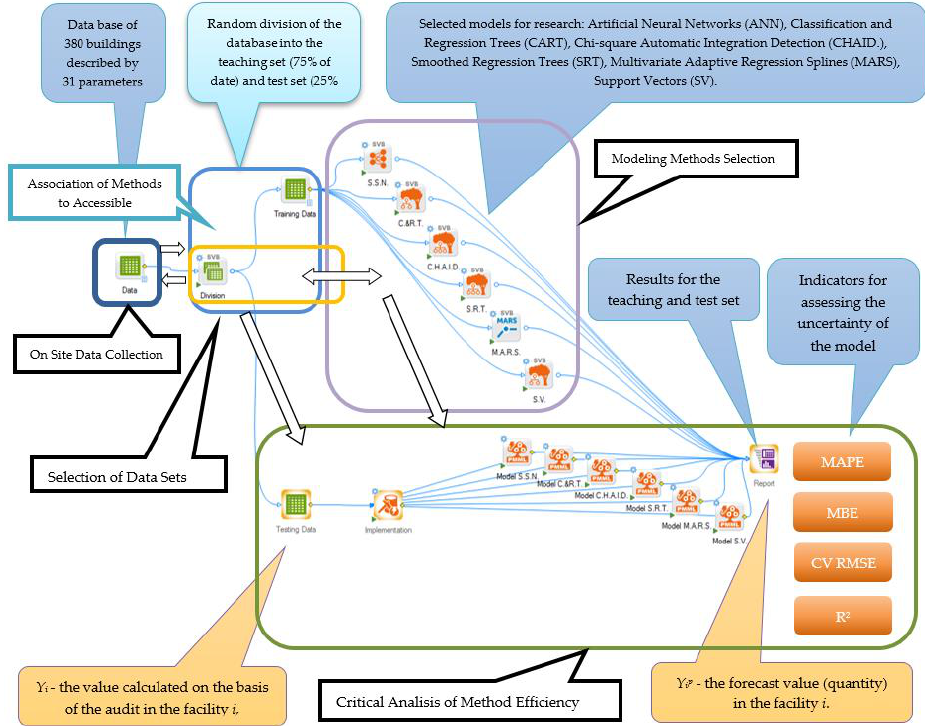
Figure 4. View of working space Data Miner visualizing global strategy of adopted methodology.